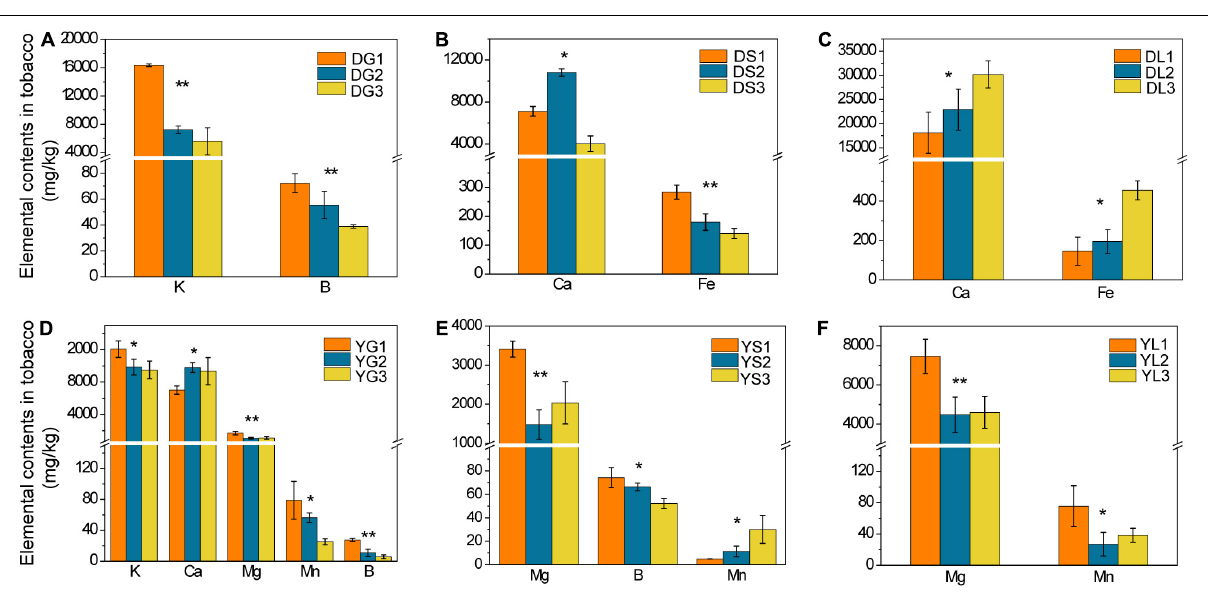
FIGURE 2 | The elemental contents in tobacco roots, stems, and leaves from Dali ( A–C , respectively) and Yuxi ( D–F , respectively). Values are the average of three replicates with a standard deviation bar. DG, DS, and DL represent tobacco roots, stems, and leaves from Dali, respectively; those followed by “1,” “2,” and “3” represent tobacco showing no, slight, and severe disease, respectively. YG, YS, and YL represent the corresponding samples from Yuxi. “**” and “*” represent the contents of the elements showing extremely significant ( p < 0.01) and significant ( p < 0.05) difference,